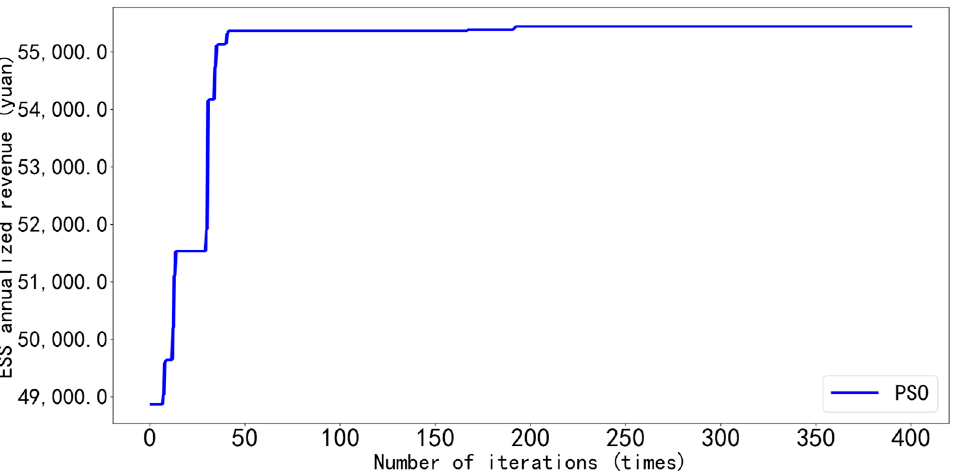
Figure 6. PSO to calculate the annualized return iteration results.